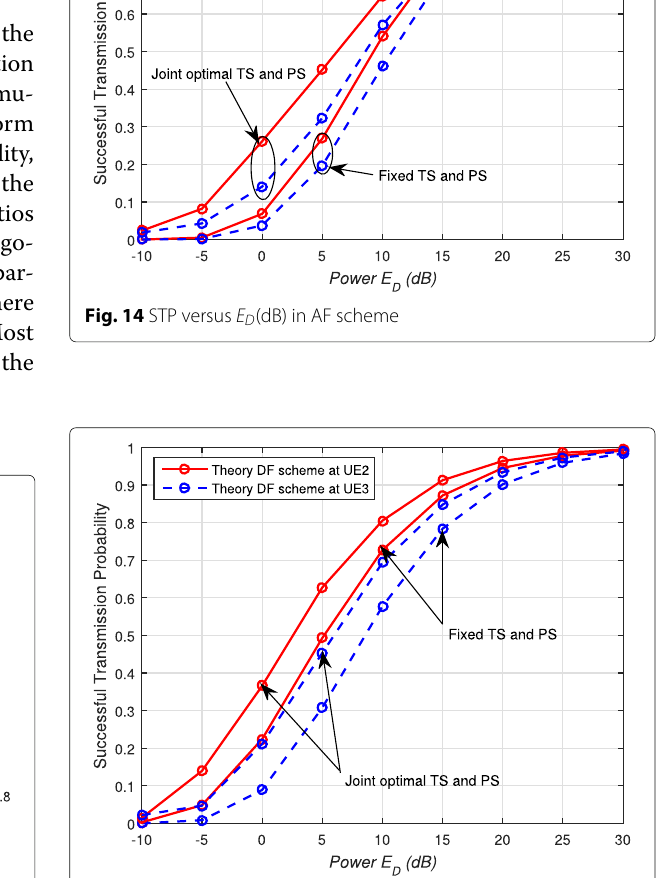
Fig. 15 STP versus E D (dB) in DF